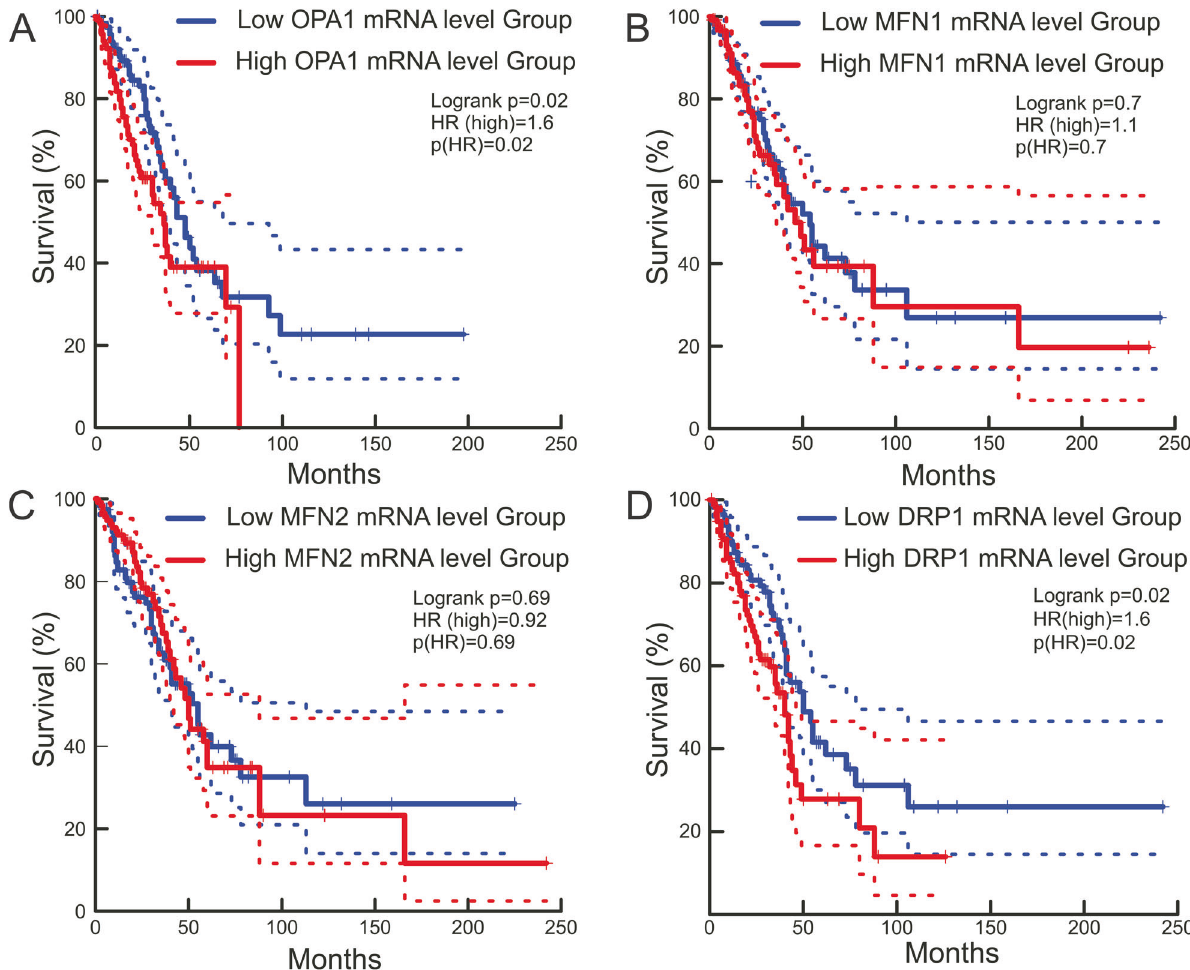
Fig. 3 Lung adenocarcinoma patients with high OPA1 and DRP1 mRNA levels treated with chemotherapy display a worse prognosis. Kaplan – Meier survival curves of lung adenocarcinoma patients in PanCancer Atlas. Red and blue lines represent survival curves of patients with lung tumor tissues with high and low expression levels of OPA1 ( A ) MFN1 ( B ), MFN2 ( C ), and DRP1 ( D ) mRNA. The cutoff value was determined as the quantile value of the expression levels of each mRNA ( n = 120). Dashed lines indicate 95% con fi dence intervals. The p values were calculated using a log-rank test. The hazard ratio was calculated with Cox PH Model. HR hazard